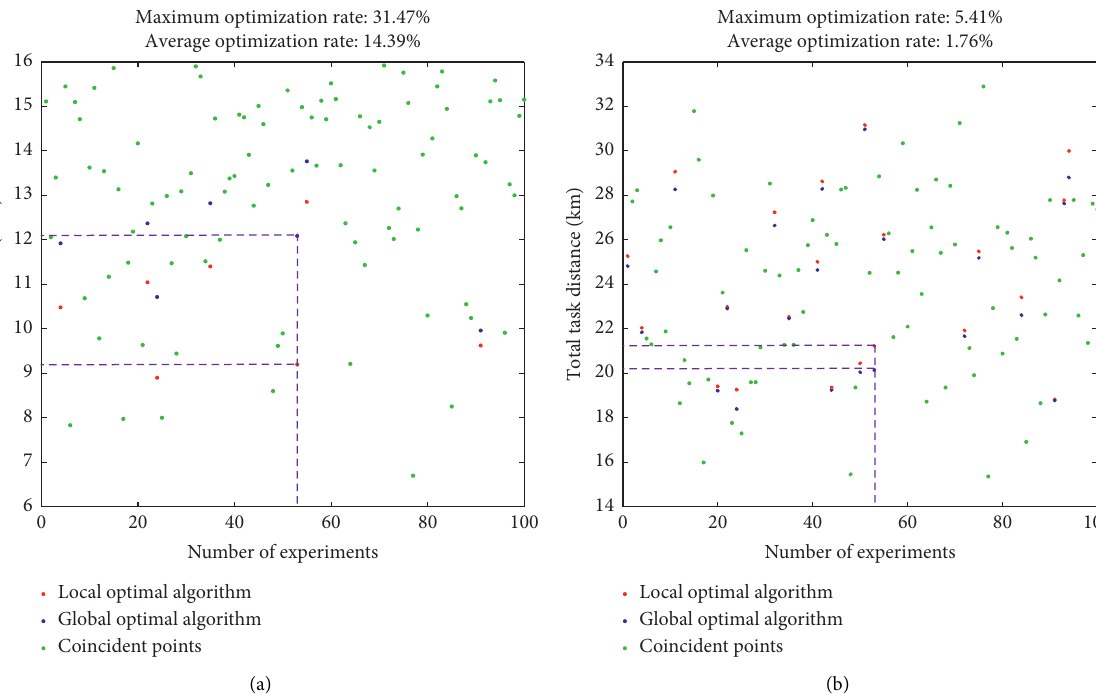
Figure 8: The results of two algorithms when R � 2 km: (a) total task time of two algorithms; (b) total task distance of two algorithms. Maximum optimization rate: 31.47%; maximum optimization rate: 5.41%.